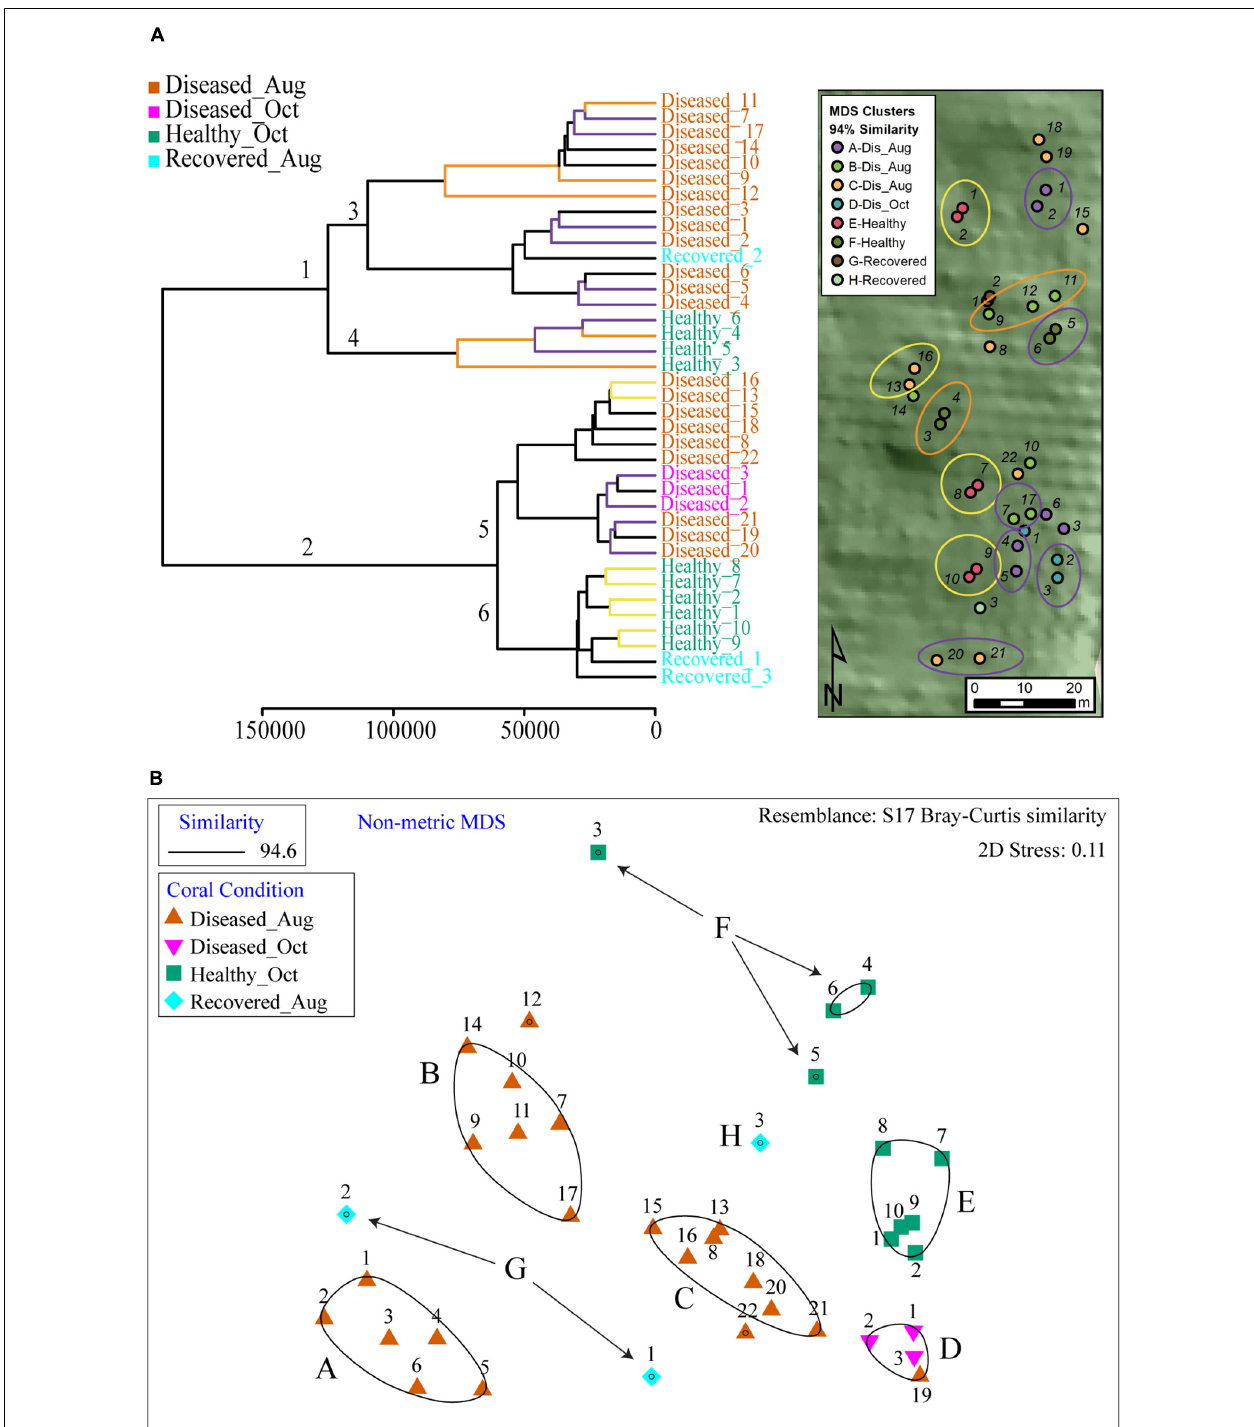
FIGURE 4 | The HCA and MDS plot of all samples analyzed in this study. (A) The healthy samples were divided across 2 major clades (clades 4 and 6) and served as basis to color healthy samples in PCA plots as green and blue in Figure 3B . The branches in HCA are colored based on location proximity deciphered from site map. The branches in yellow represent samples that are within the same sub-clade and are neighbors in the site map shown as circles (e.g., healthy samples 1 and 2 are immediate neighbors in site map). The branches in purple and orange are present across two sub-clades. The branches with either color represent neighboring samples in site map (e.g., healthy samples 3 and 4 in orange branches are neighbors in site map. Similarly, healthy samples 5 and 6 in purple branches are neighbors in site map). (B) Shows output of MDS analysis where diseased samples are grouped in four clusters and healthy samples are grouped in two clusters.